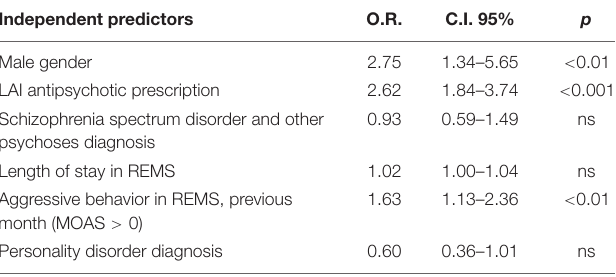
TABLE 2 | Binary logistic regression analysis of factors associated with antipsychotic polypharmacy. Independent predictors